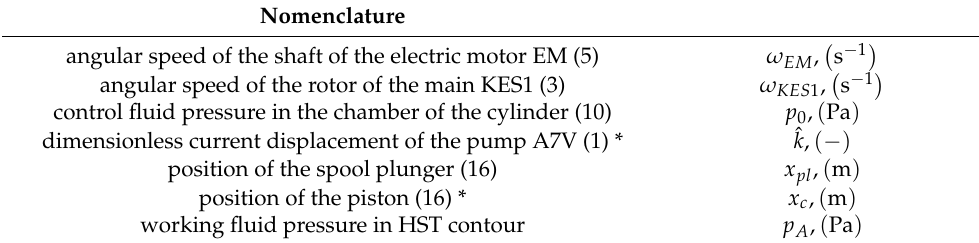
Table A1. The list of variables, describing the test stand dynamic behavior, Equation (11) in the main